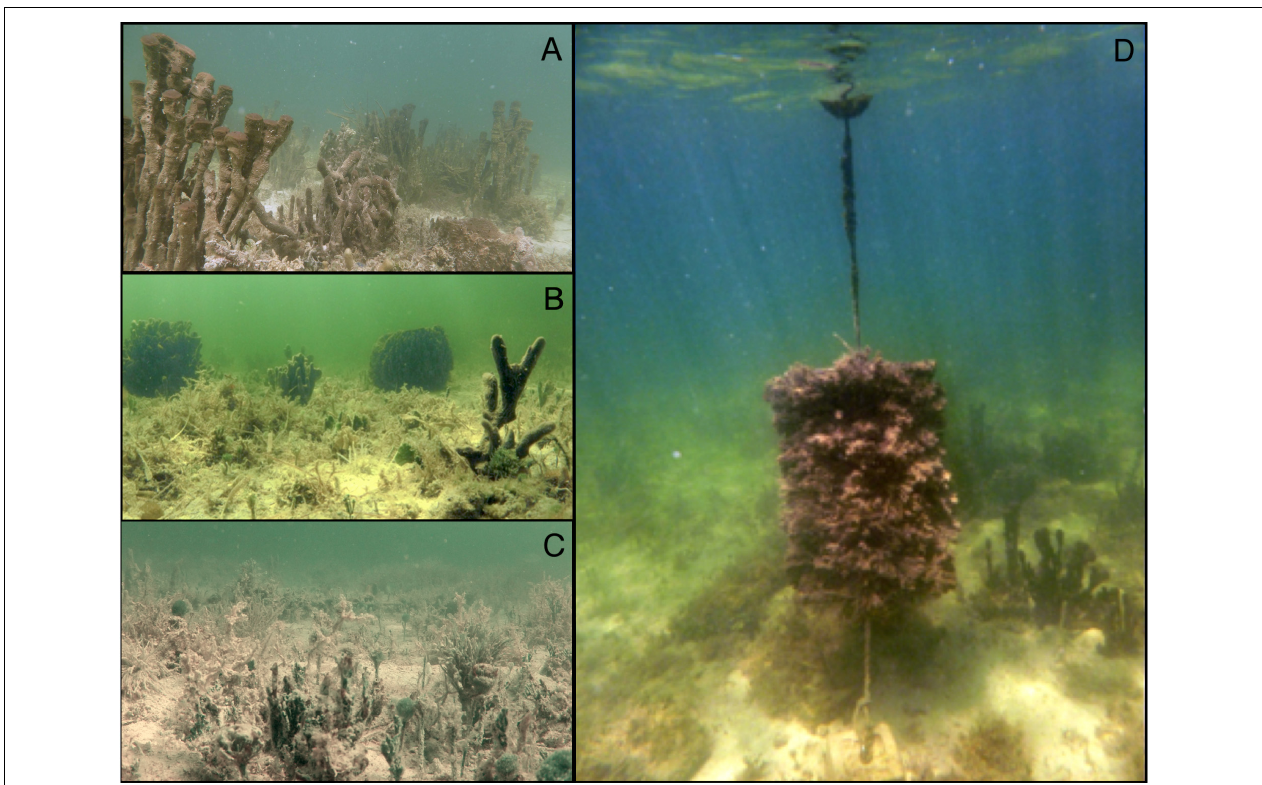
FIGURE 1 | Example of healthy hardbottom habitat with many large sponges present, restored hardbottom habitat with sponge transplants attached to concrete pavers, and degraded hardbottom devoid of sponges ( A–C , respectively). Panel (D) is a photo of a larval shag collector at an undisturbed hardbottom site; two of these were moored at each experimental site within each